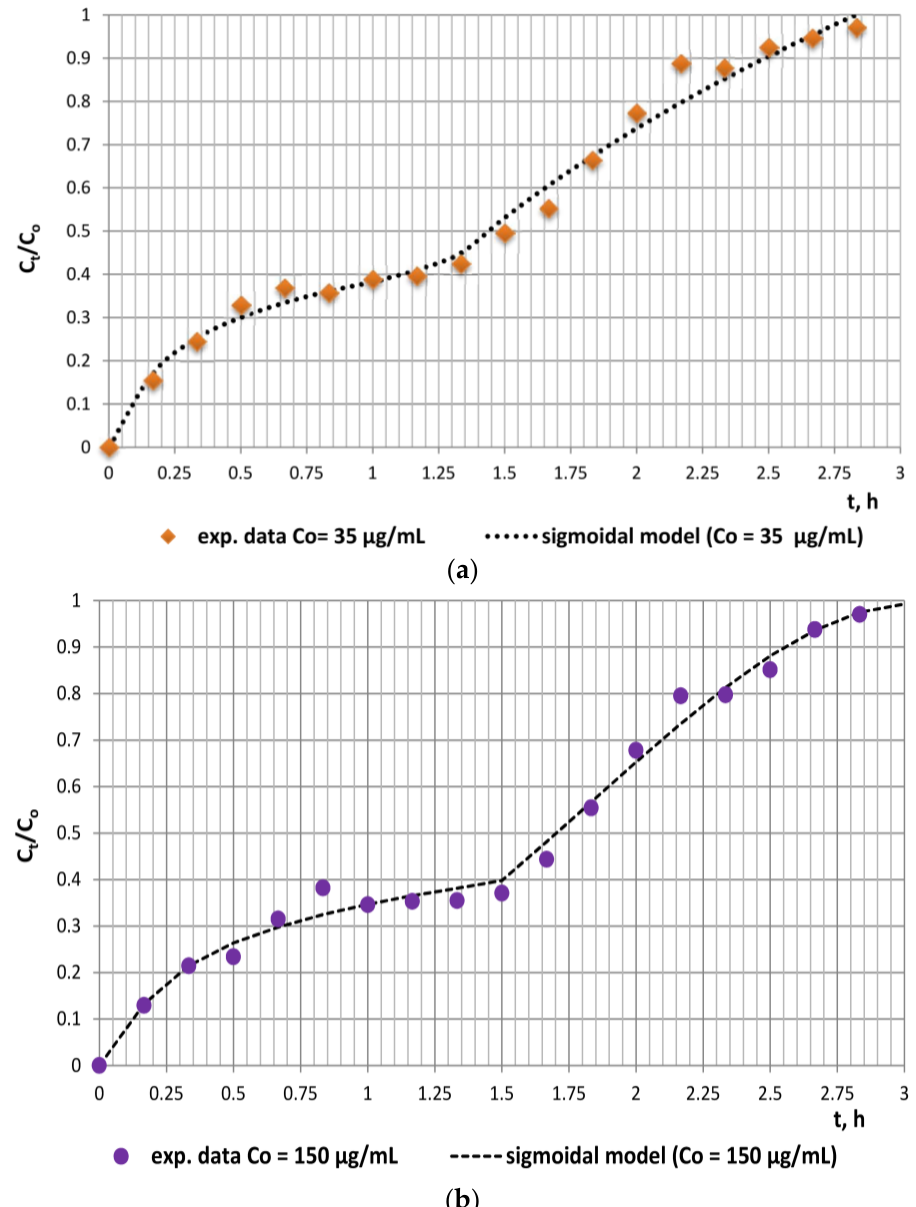
Figure 3. Applicability of the sigmoidal model to the experimental in vitro release data: ( a ) solid doxycycline concentration 11.03 µg/mg, doxycycline-loaded fodder w = 133.3 mg; ( b ) solid doxycycline concentration 41.6 µg/mg, doxycycline-loaded fodder w = 137.8 mg.